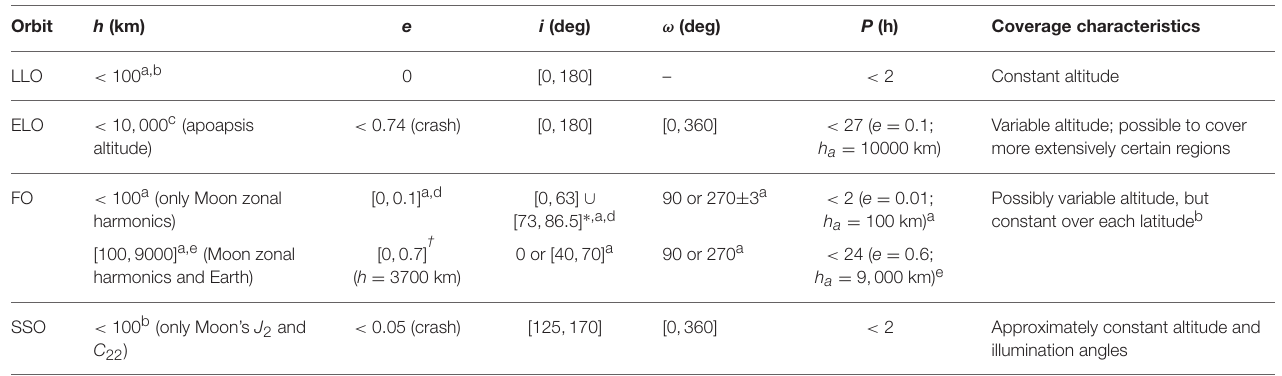
TABLE 2 | Characteristics of Keplerian and perturbed Keplerian lunar remote sensing orbits. Orbit